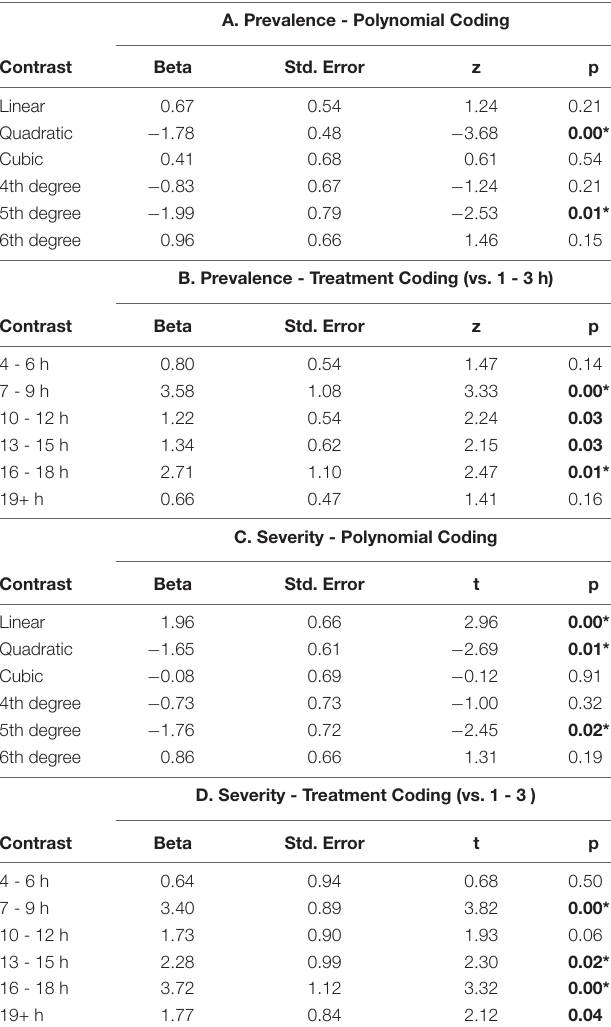
TABLE 3 | Regression analysis (Playing